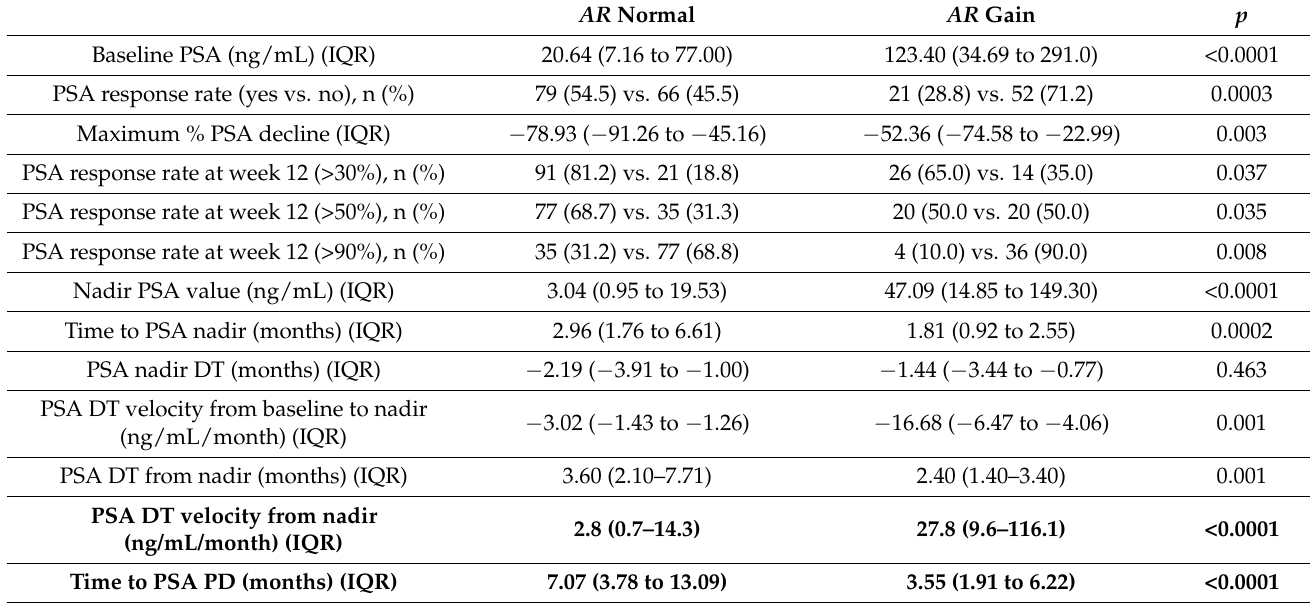
Table 3. Correlation of plasma AR copy number and PSA kinetics.